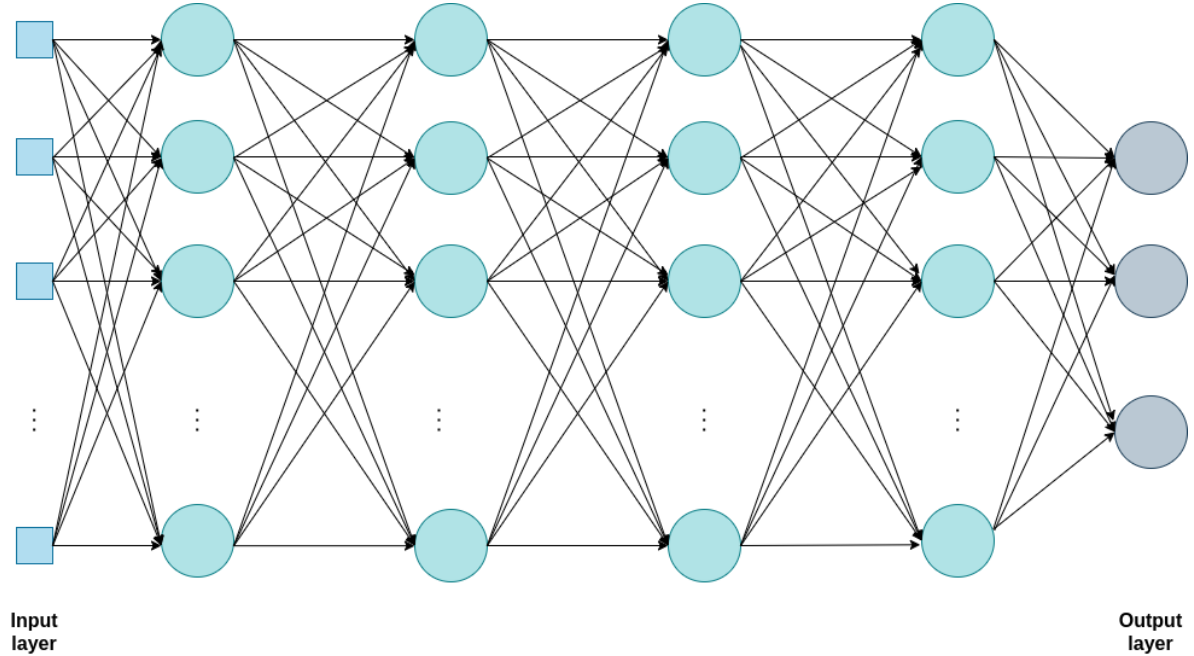
Figure 8. Base neural network architecture for pulse shape